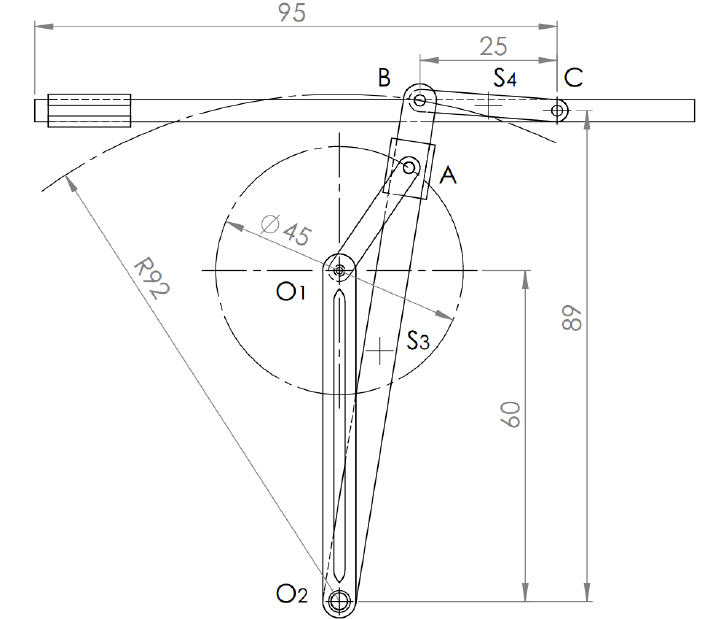
Figure 5. 3D model of studied rocker